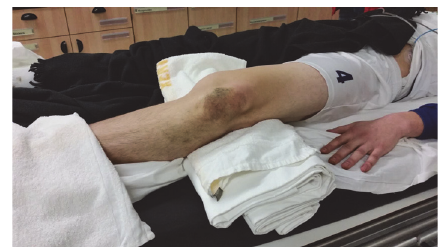
Figure 1: Dislocation of the left knee.